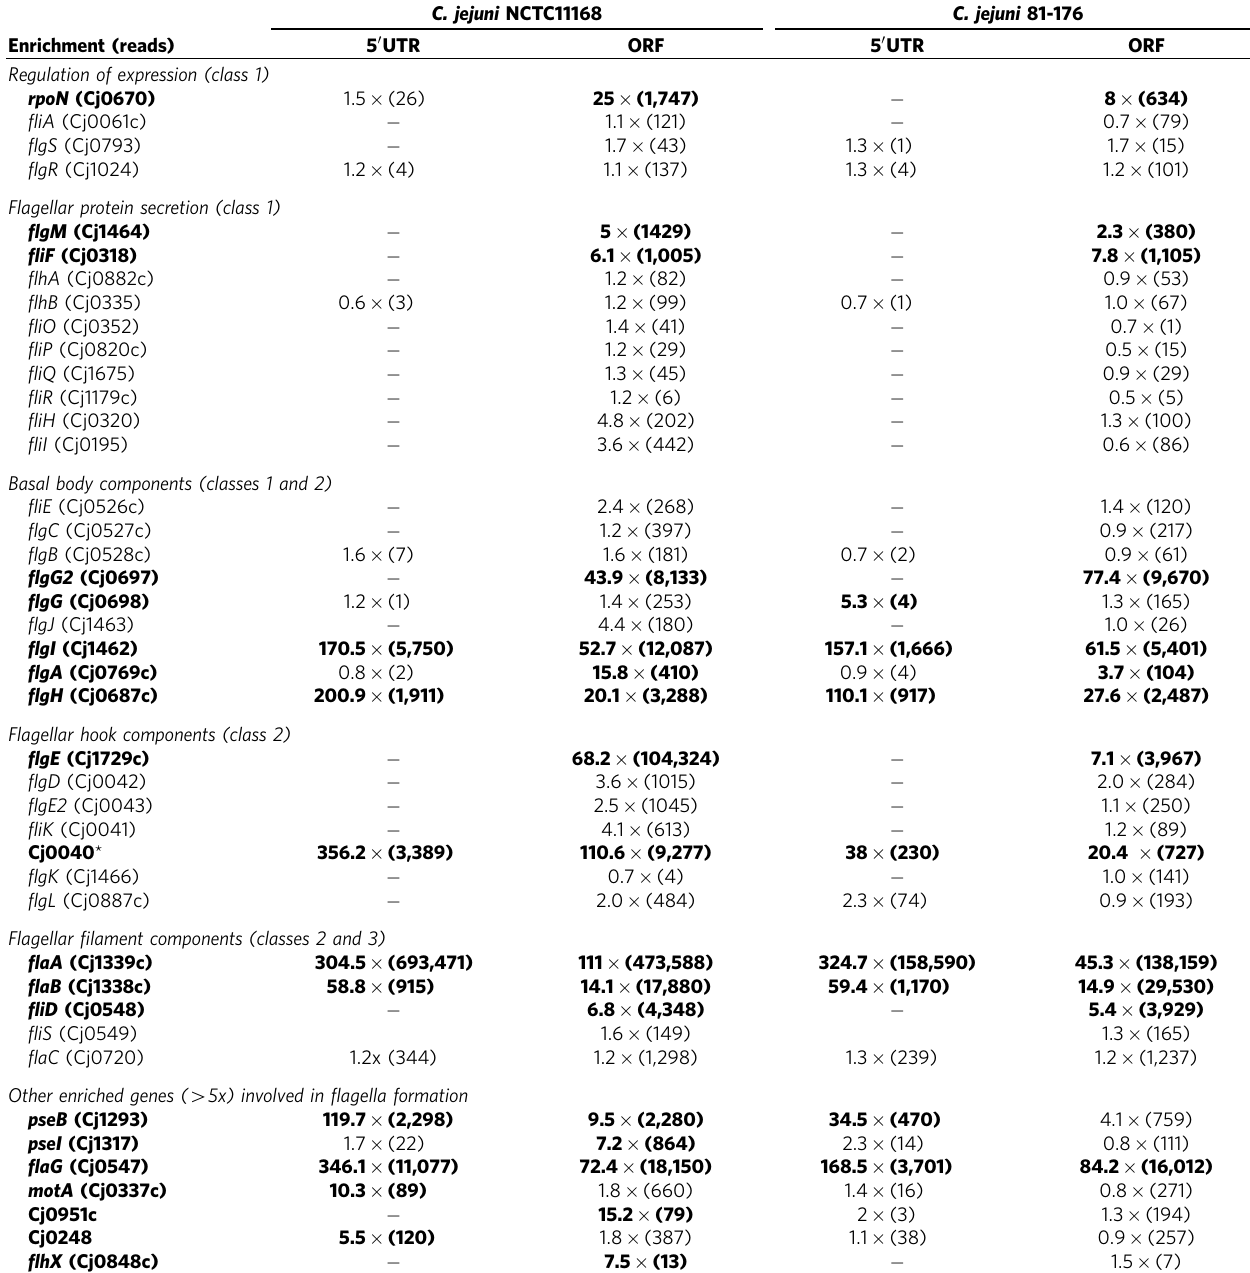
Table 1 | Enrichment of genes involved in flagellar biosynthesis in the CsrA coIP data. C. jejuni NCTC11168 C. jejuni